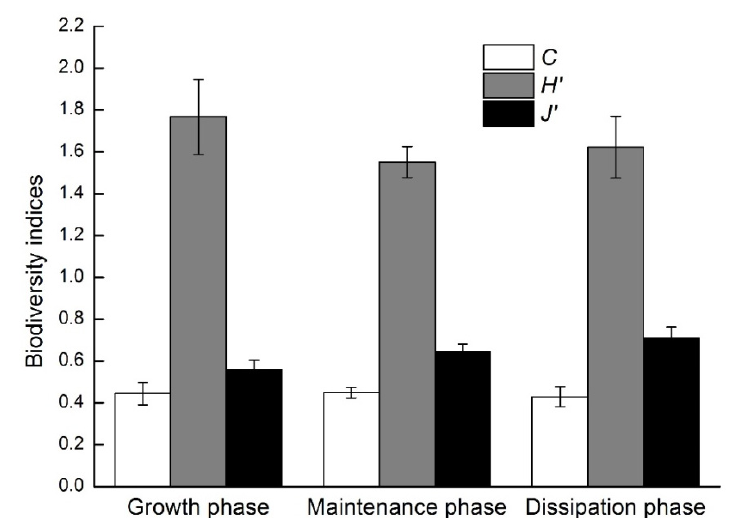
Figure 7. The indices of simplicity ( C ), diversity ( H ′ ), and evenness ( J ′ ) in different phases of the P. donghaiense bloom; the data were presented as the mean values ± SE.